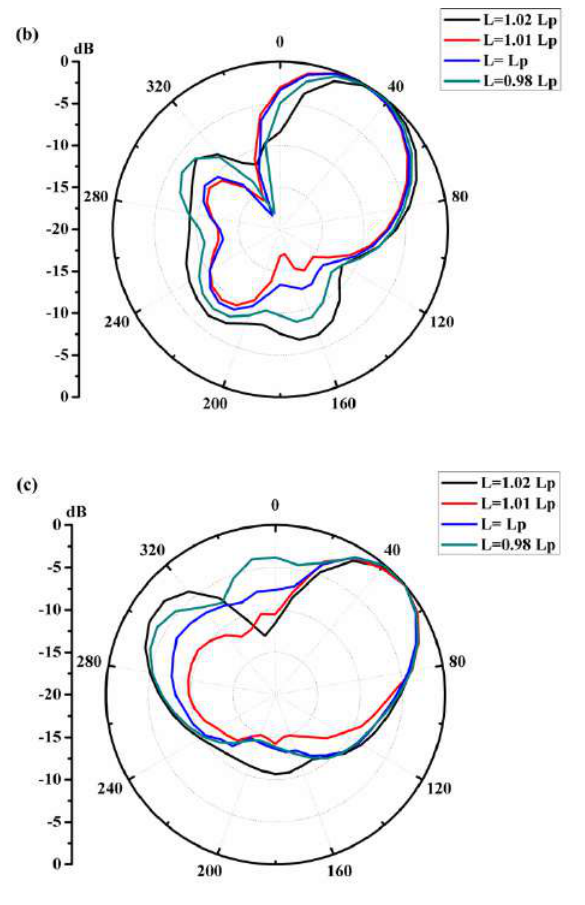
FIGURE 5. (a) S 11 , (b) E plane, and (c) H plane radiation pattern, for different values of L.